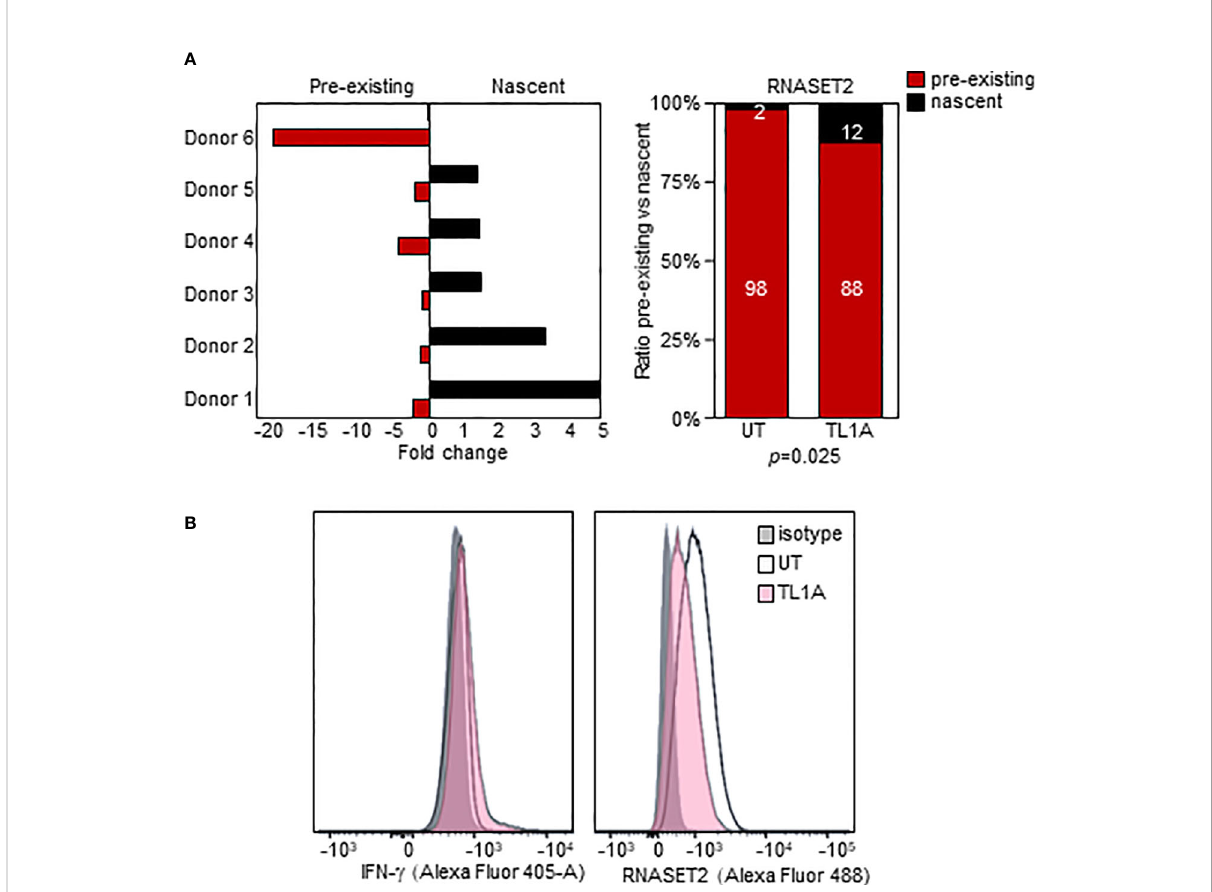
FIGURE 5 TL1A activation inversely impacts nascent and pre-existing RNASET2 transcripts. (A) Increase in nascent ( p =0.047) and decease in pre-existing ( p =0.03) RNASET2 transcript from PBMC cells treated with TL1A. Levels are plotted as fold over expression in untreated cells ( n =6). (B) Intracellular IFN- g protein increases and RNASET2 protein decreases following TL1A stimulation. Flow cytometry analysis representative of three with similar